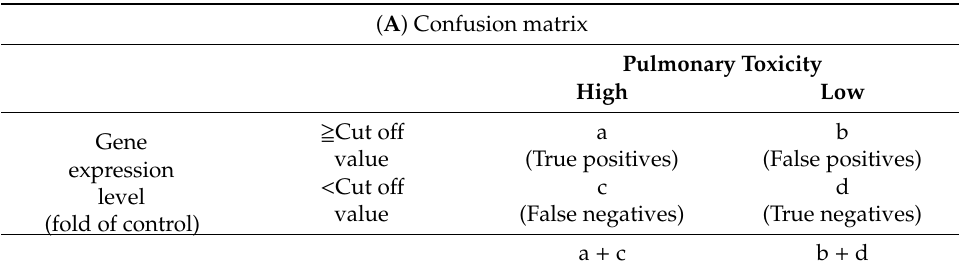
Table A1. ( A ) Confusion matrix. ( B ) Example of confusion